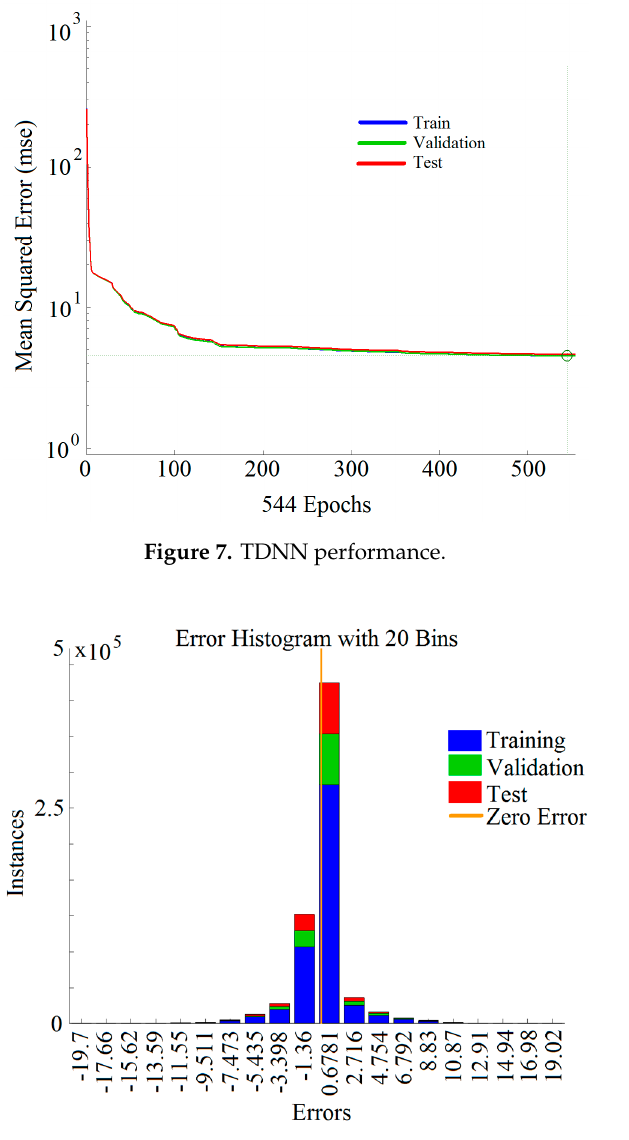
Figure 8. TDNN error histogram.